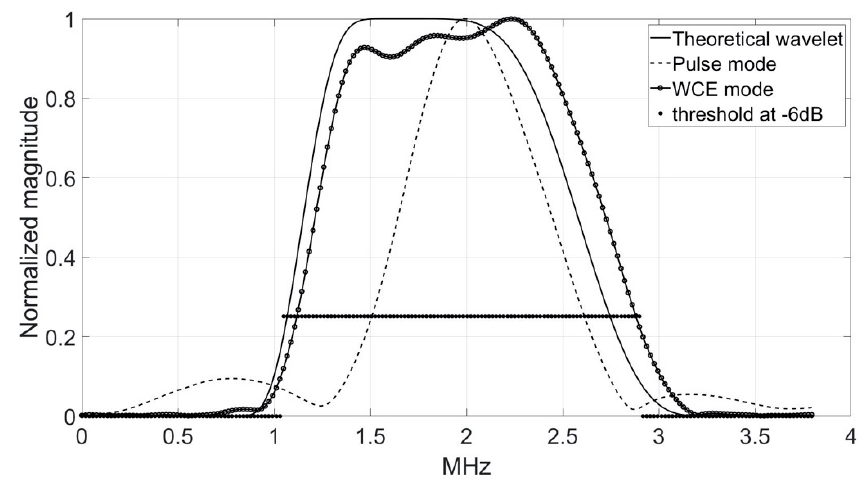
Figure 8. Comparison of the temporal representations ( top ) and frequency spectra ( bottom ) of the theoretical analyzing wavelet (solid line), the transmitted pulse signal (dashed line), and the pseudo-wavelet (dotted line) for the 2.25 MHz-transducer.